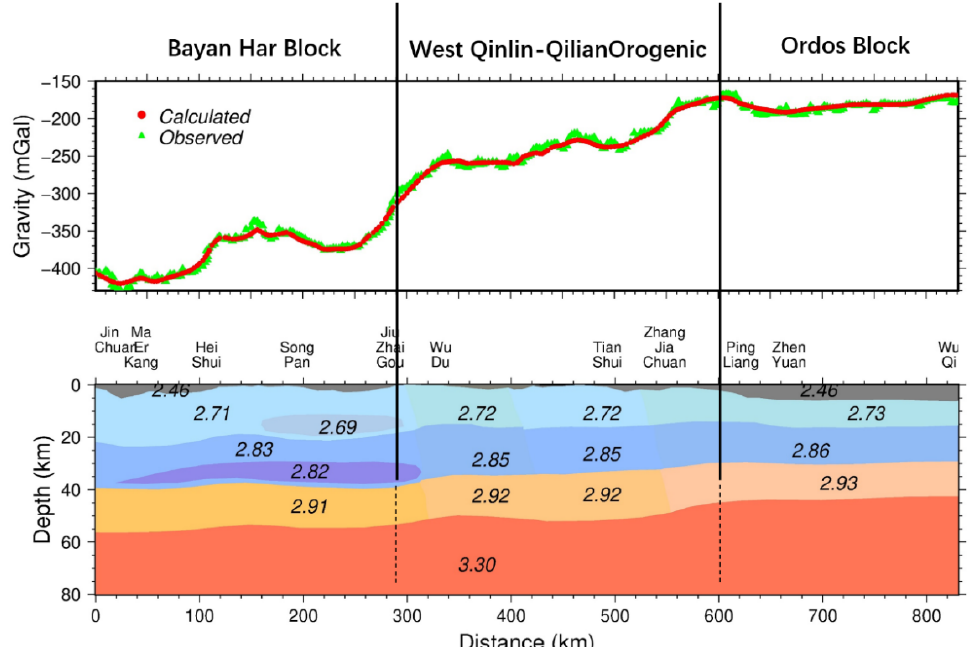
Figure 3. The crustal density structure along with the Barkam–Wuqi profile. The upper figure shows observed gravity anomalies and calculated gravity anomalies, which is derived from the forward calculation of density anomalies in the lower figure. The black lines represent a block boundary, where there is a greater lateral difference in density, and the dotted line indicates that the information of the lower crust is uncertain. The numbers in the lower figure represent crust density (unit: g/cm 3 ). Table 3. Comparison of the crustal structures of different blocks along with the Barkam–Wuqi profile. Bayan Har Block West Qinling–Qilian Orogen Ordos Block Unit: km Unit: km Unit: km Average: 2.2 Average: 1.1 Average: 2.9 The bottom boundary of the cover layer (0.4~5.1) (0.4~2.4) (1.1~5.1) Average: 20.8 Average: 14.8 The bottom boundary of the upper crust Average: 38.8 The bottom boundary of the middle crust The bottom of the lower